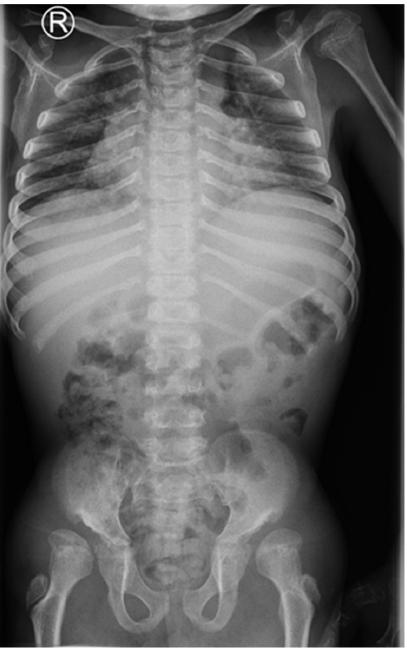
Figure 2. Dysplastic changes of the acetabulum, coxa valga, lucencies of the proximal femora, flattened vertebral bodies (platyspondyly), 11 years of